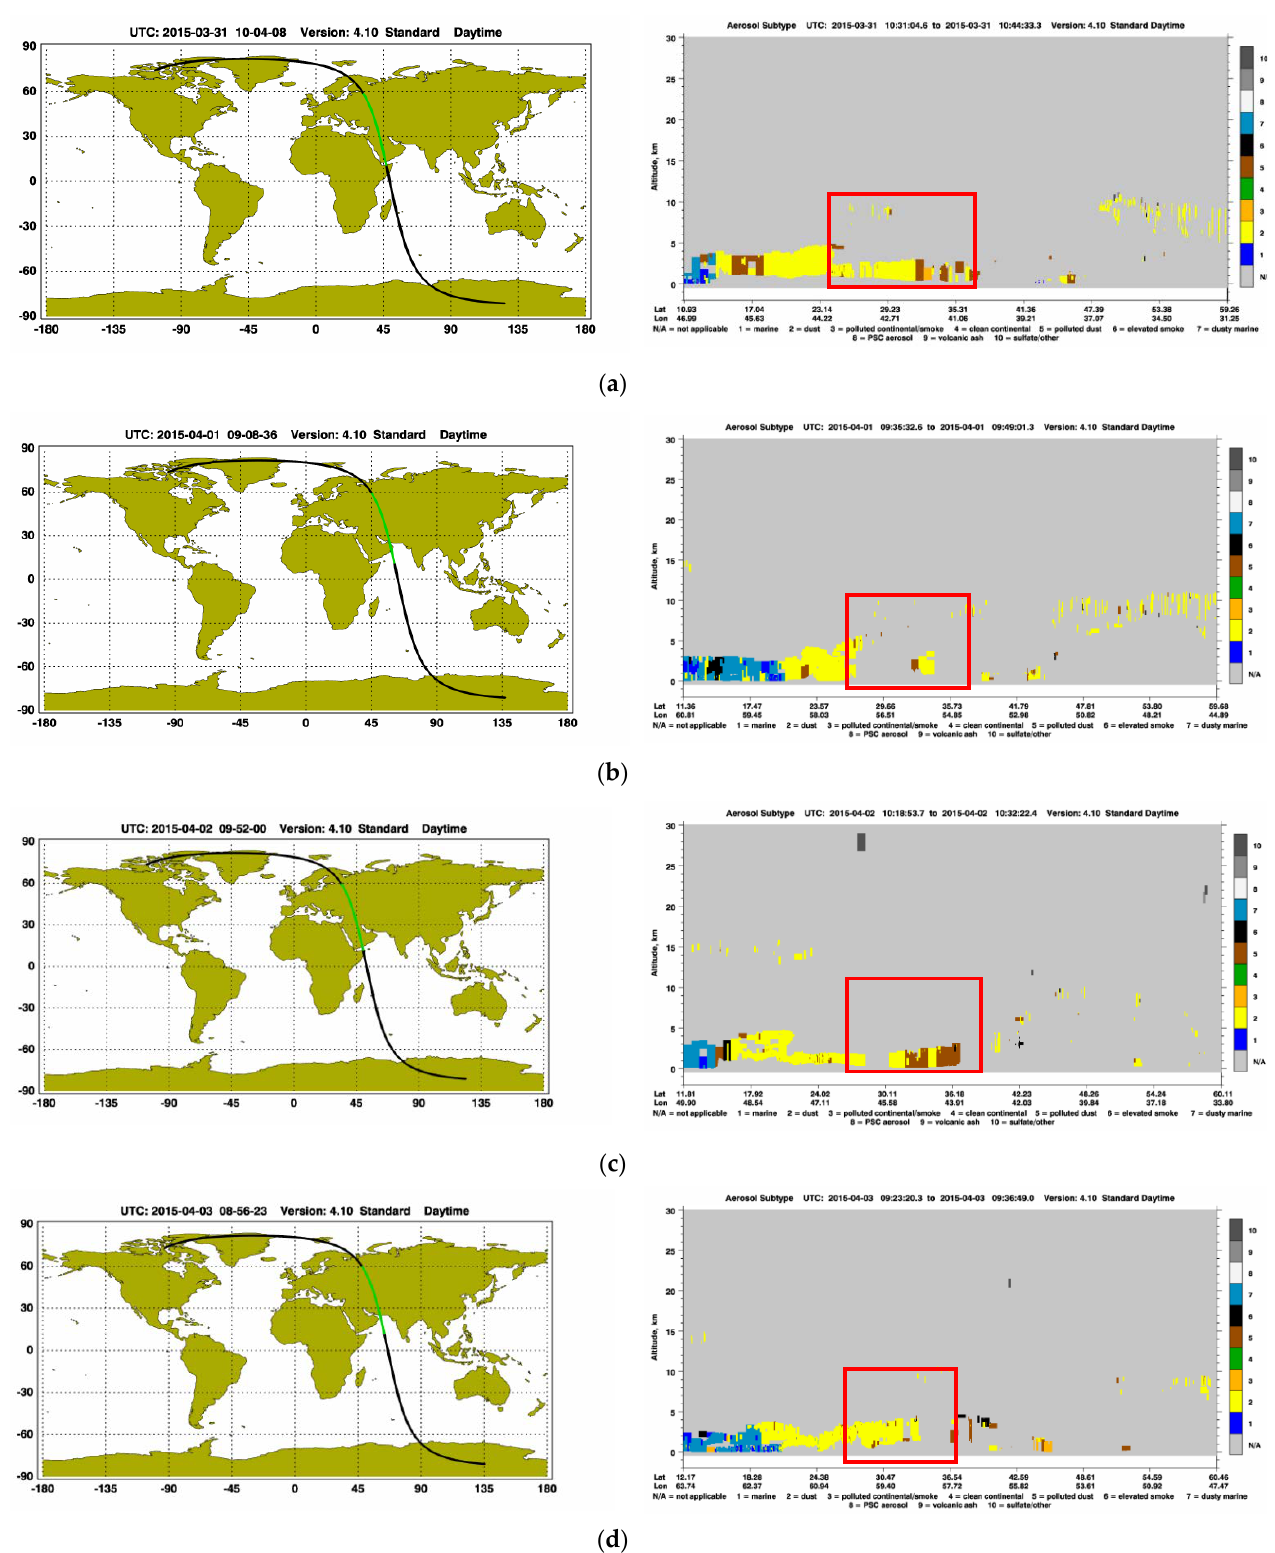
Figure 5. CALIPSO path ( left panel) and aerosol subtype vertical profile as derived from CALIOP measurements ( right panel): ( a ) 31 March 2015, ( b ) 1 April 2015, ( c ) 2 April 2015, ( d ) 3 April 2015.